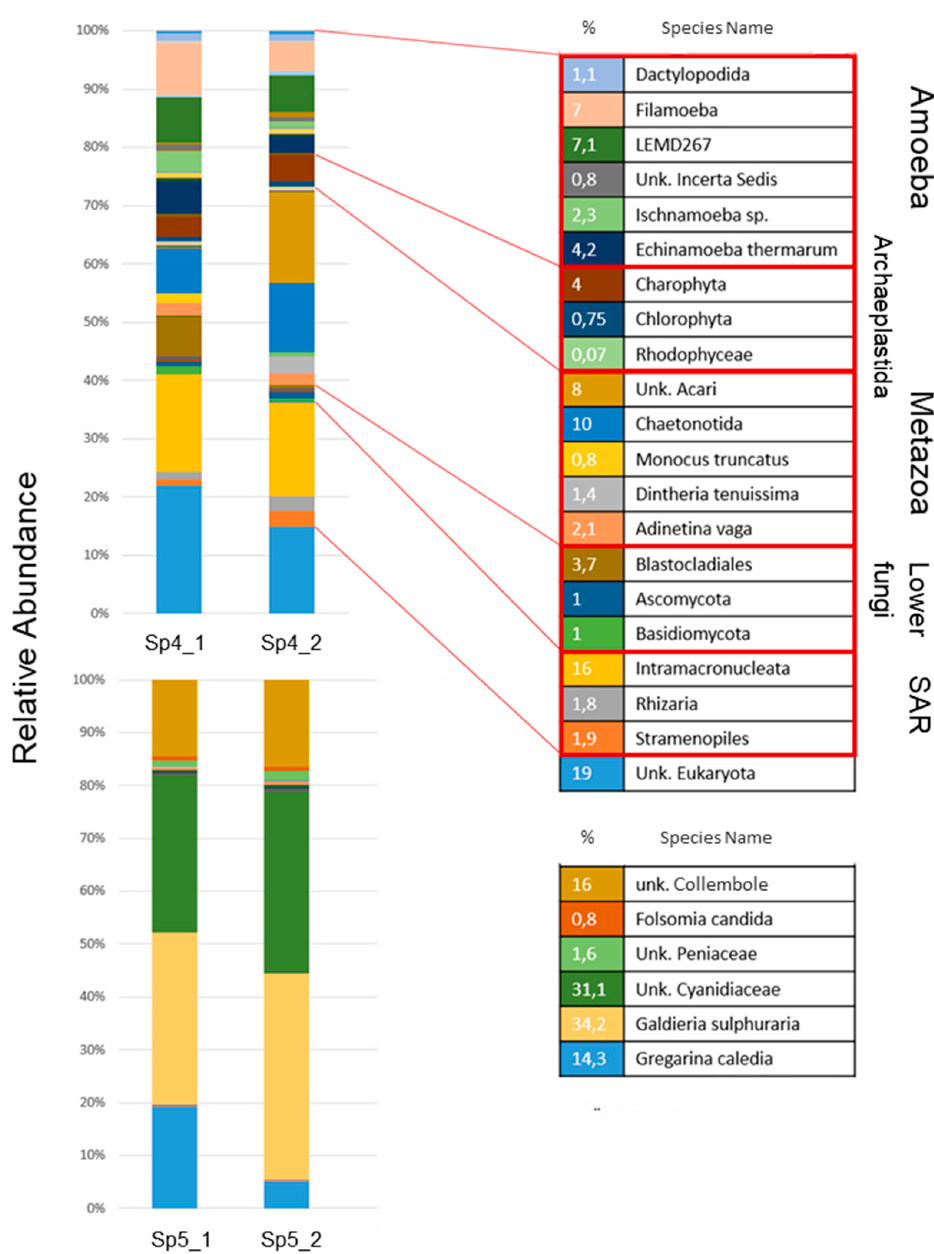
Figure 7. Eukaryotic community composition of a neutral pH (water stream biofilm SP4) and extreme (fumarole biofilm SP5) biome. Taxonomic groups are listed which show at least 0.80% of the total OTU abundance (except for the Rhodophyceae (0.07%) from the stream water sample to show the contrast to the fumarole and Chlorophyta to distinguish them from Charophyta ). In the stream water sample, 21 species groups are listed which represent 98.02% abundance of the total OTUs, and six groups are shown in the fumarole samples, which represent 97.90% of the total OTUs (Unk,